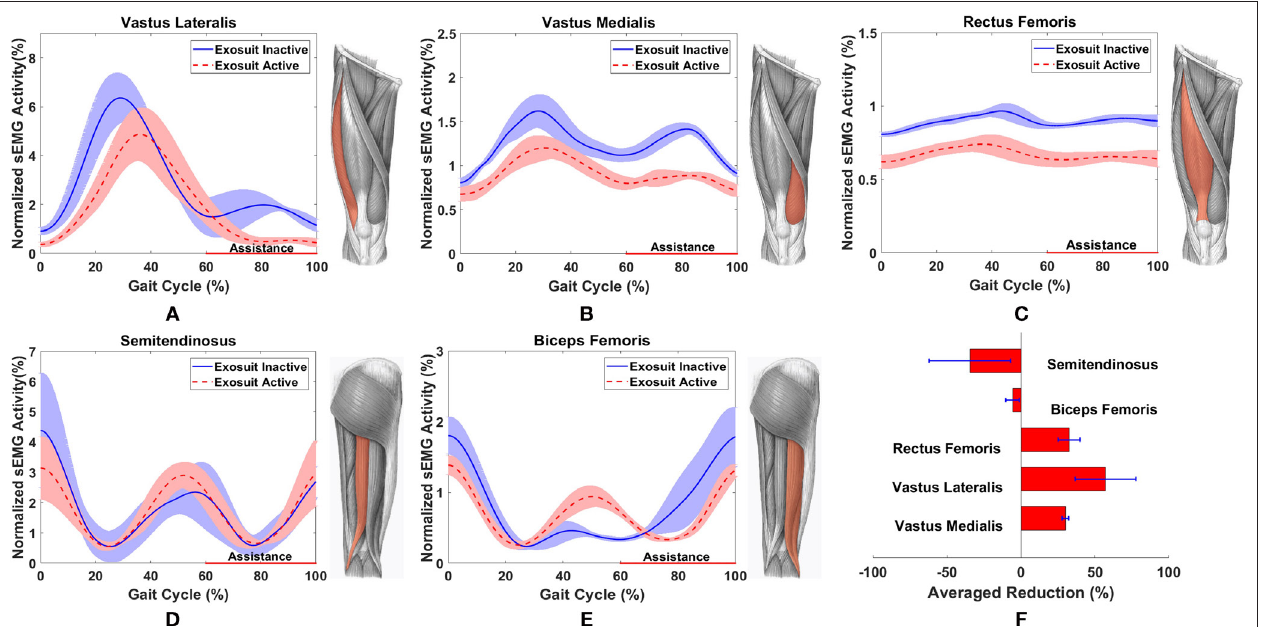
Figure 9 | Normalized sEMG signals with reference to seated resting activity and maximum VMC for: (a) VL, (B) VM, (c) ST, (D) RF and (e) BF averaged for 5 gait cycles for a single test participant. (F) Averaged reduction for ST( n = 3), BF ( n = 2), RF ( n = 2), VL( n = 3), VM ( n = 3) for multiple test